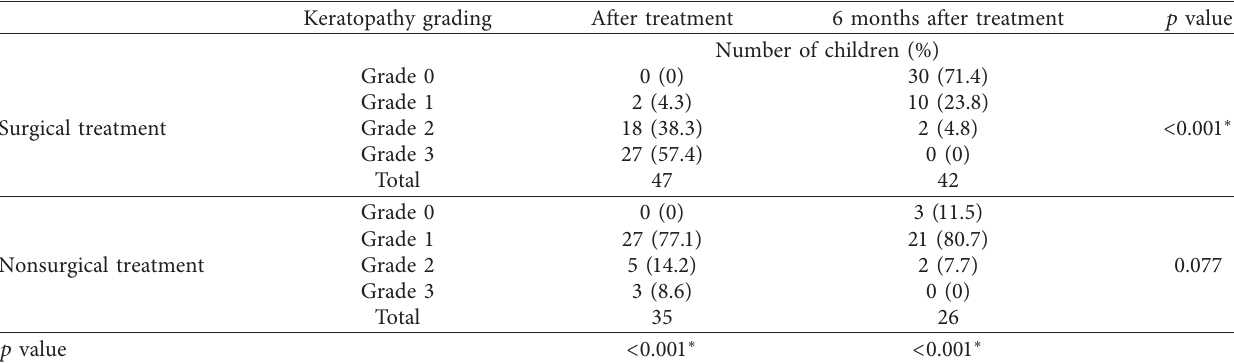
Table 2: Severity of keratopathy in the two groups at baseline and 6 months after treatment.